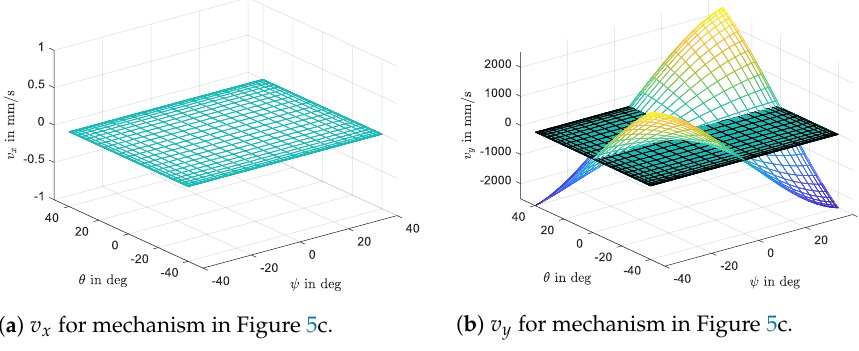
Figure 7. v x and v y for the mechanism in Figure 5c.